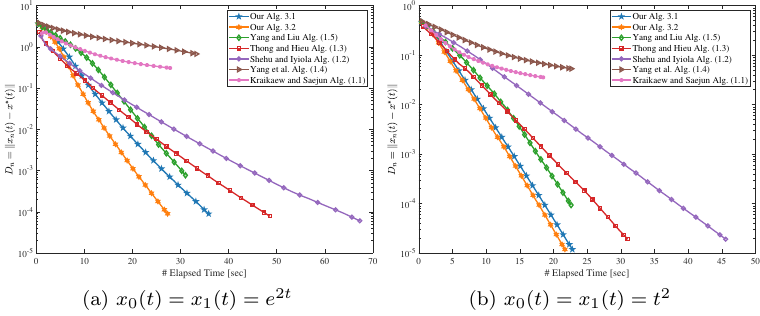
Figure 2. Numerical results for Example